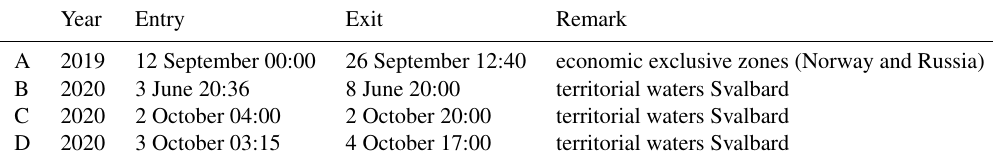
Table 2. List of restricted periods for which atmospheric measurements were not permitted. Time periods are given in